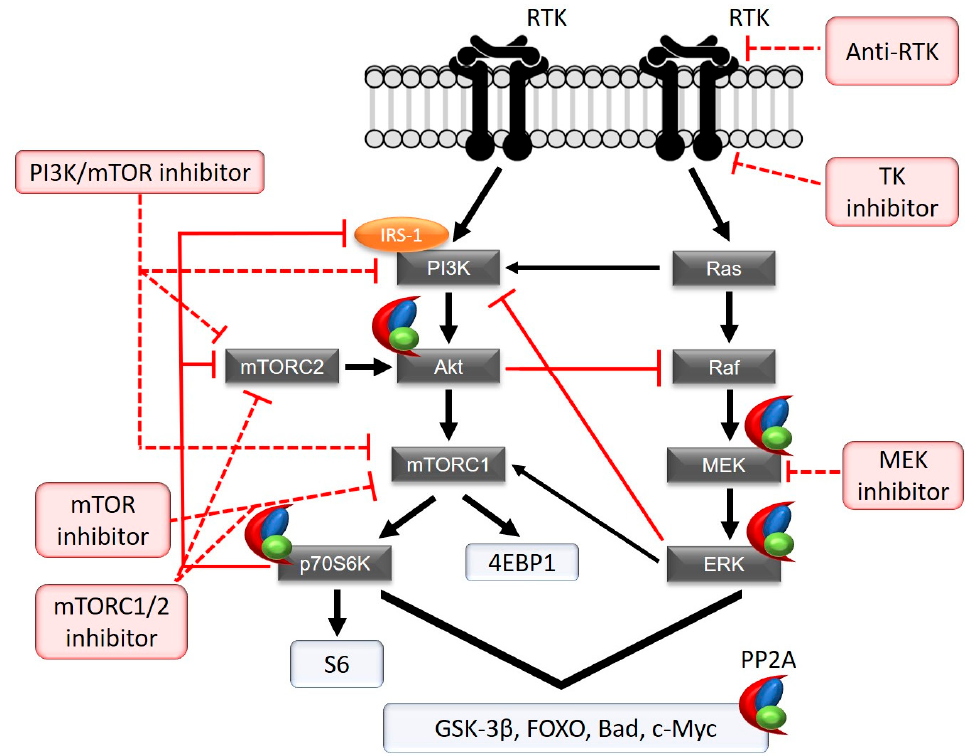
Figure 1. Schematic overview of the PI3K and MAPK pathways and important substrates. Black arrows represent activation. Red lines represent endogenous inhibition through feedback/cross-talk. Dotted red lines represent inhibition with pharmacologic kinase inhibitors. The heterotrimeric PP2A complex is represented in red (A subunit), blue (B subunit) and green (C subunit). Both pathways can